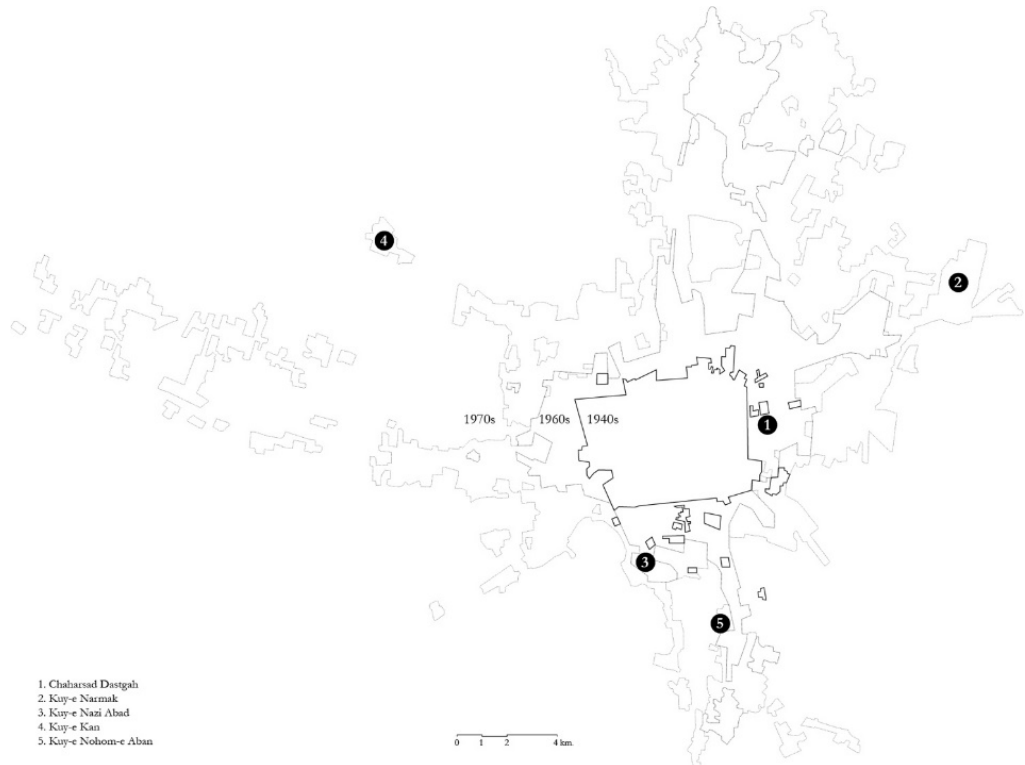
Figure 7. Tehran’s Urban Growth (1940s to the 1970s) and the locations of the early social housing projects. Source: author. Urban Planning, 2019, Volume 4, Issue 3, Pages